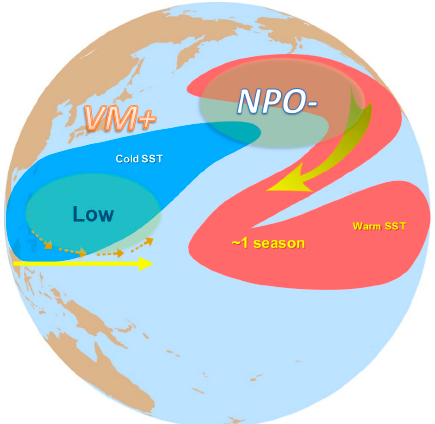
Figure 11. Schematic figure illustrating how anomalous SST in the tropical Pacific associated with the VM causes an anomalous cyclonic flow over the WNP (western North Pacific) and westerly anomalies in the western equatorial Pacific that tend to intensify the WNP summer monsoon (WNPSM) as well as the SCSSM.